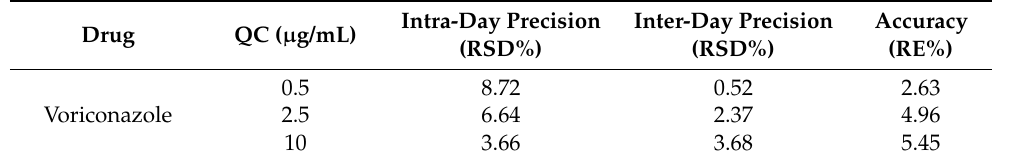
Table 2. Inter- and intra-day precision and accuracy for voriconazole in human serum (data are based on assay of six replicates on three different